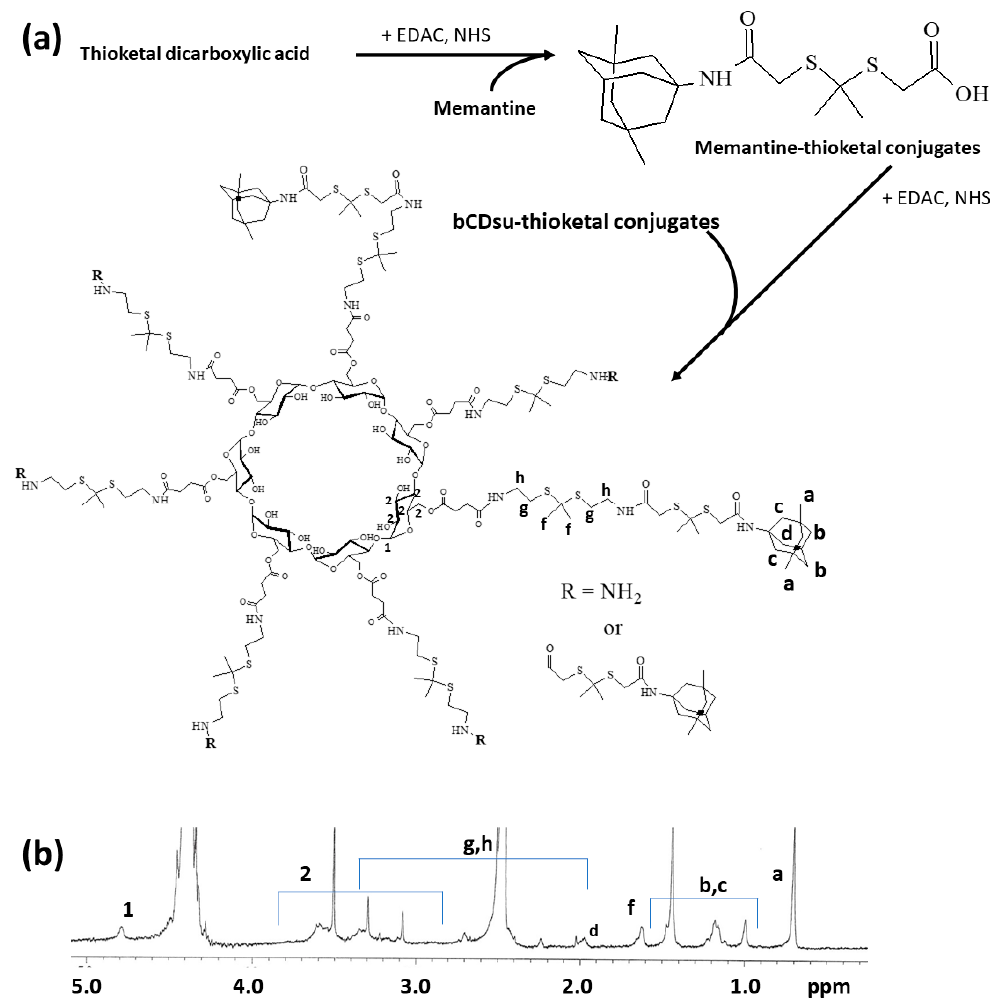
Figure 2. ( a ) Synthesis scheme and ( b ) 1 H NMR spectra of bCDsuMema conjugates. The 1 H NMR spectra of memantine and thioketal dicarboxylic acid are shown in Figure S1.